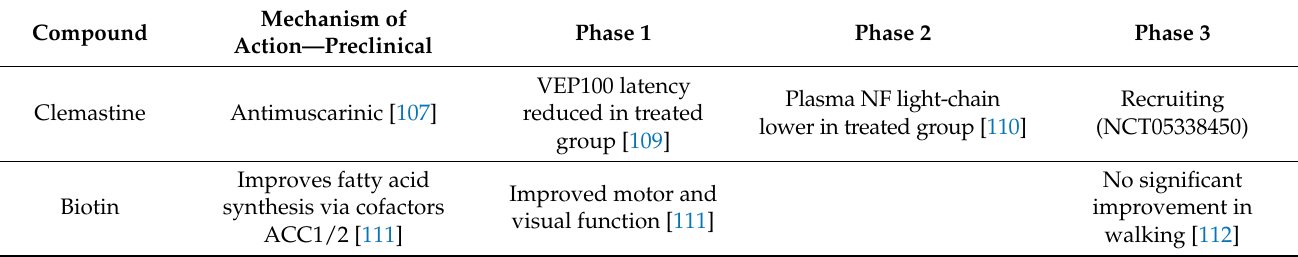
Table 1. Preclinical results and clinical trial outcomes related to CNS